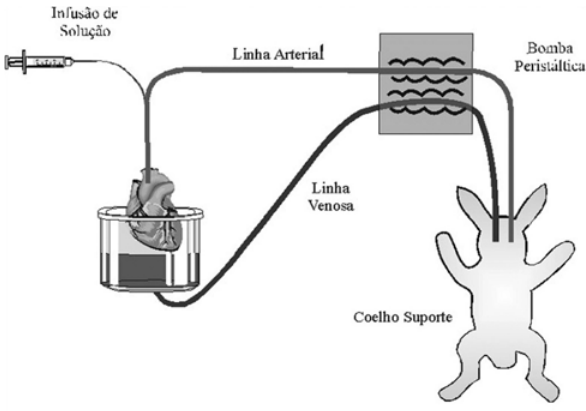
Fig. 2 - Esquema de coração